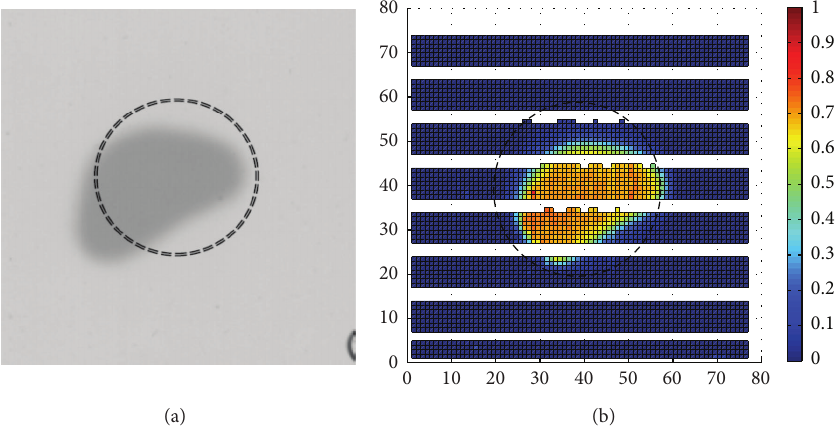
Figure 20: (a) The gafchromic EBT film image and (b) the eye-shaped image, calibrated. Axes are in fibers number (fiber size 500 𝜇